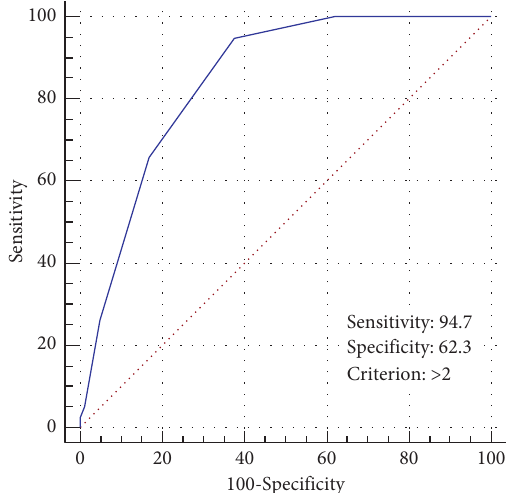
Figure 2: ROC analysis of combined risk factors for predicting DILI in SR/IR